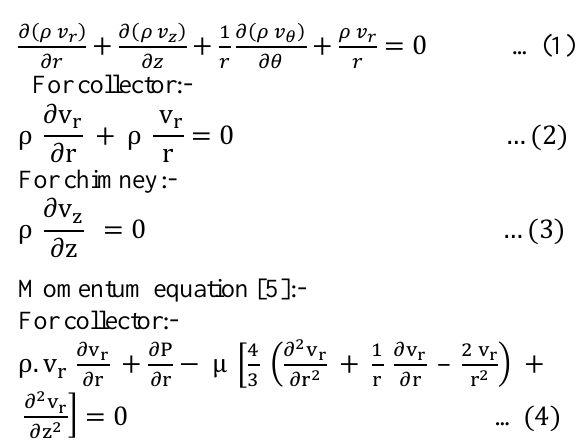
Fig. 1. Solar chimney power plant